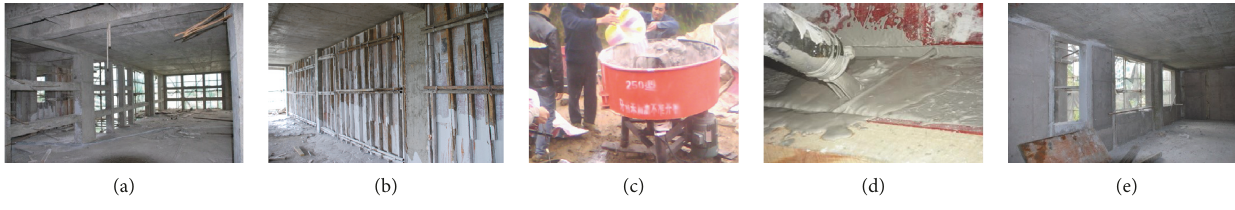
Figure 7: Construction technology of composite wall. (a) Reinforced concrete grid frame. (b) Template installation. (c) Slurry preparation. (d) Phosphogypsum castings. (e) Form stripping.